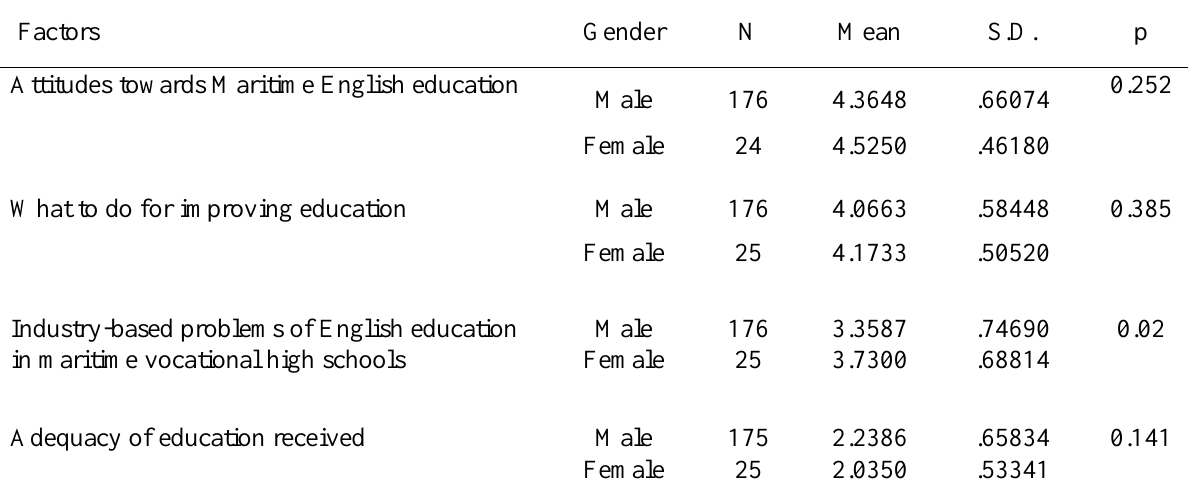
Table 7. Distribution of the average scores of participants on Maritime English education by gender Factors